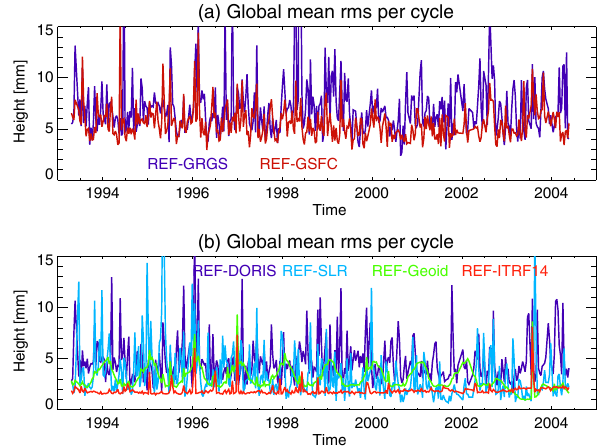
Figure 3. Time series of the global mean rms per cycle of grid- ded radial orbit differences for REF minus GSFC (dark blue) and REF minus GRGS (red, a ); REF minus DORIS (dark blue), REF minus SLR (light blue), REF minus Geoid (green), and REF minus ITRF14 (red, b